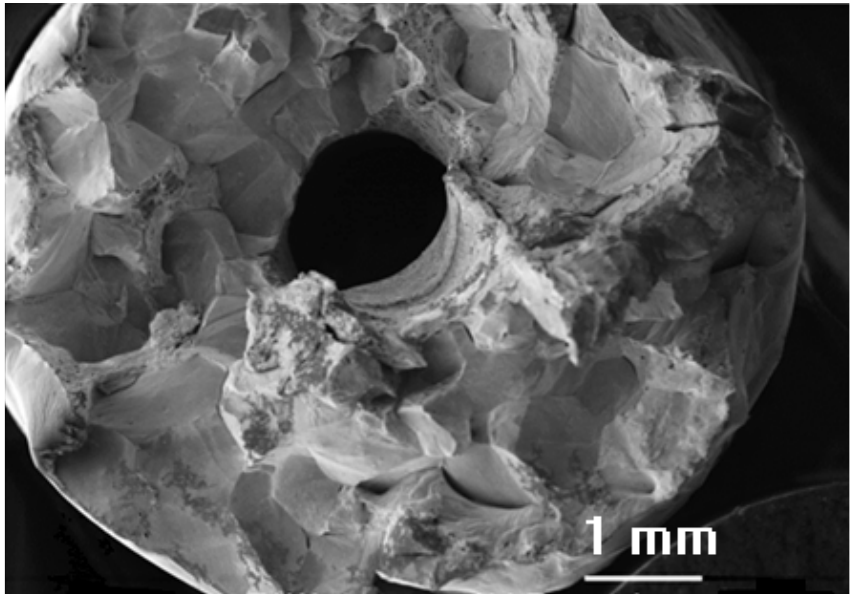
Figure 3. The fracture surface of a tensile specimen of a TRIP steel fractured at 800 °C. (The central hole is the site of a thermocouple sheath) [3].